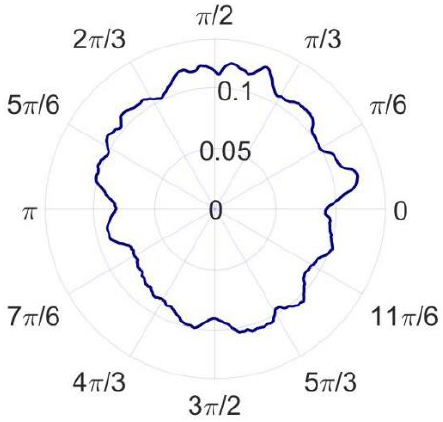
Figure 15. Roundness error of the standard workpiece.